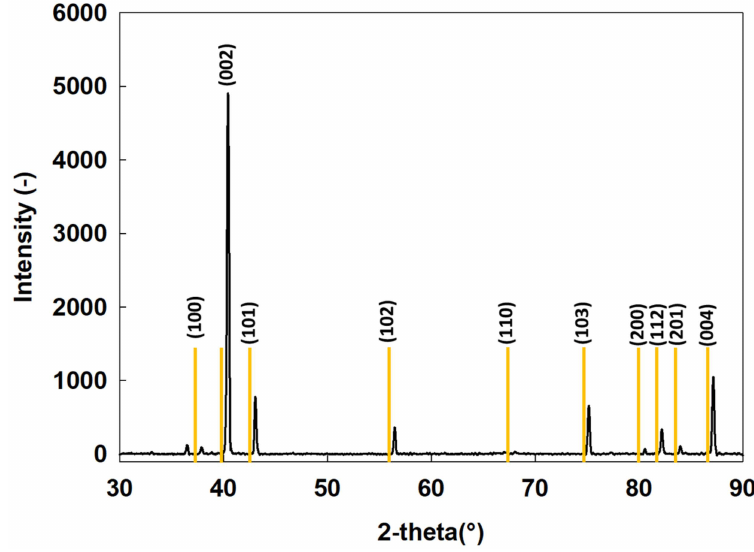
Figure 1. X-ray diffraction pattern of AZ31 magnesium alloy substrate. Table 1. Roughness characterization of AZ31 magnesium alloy